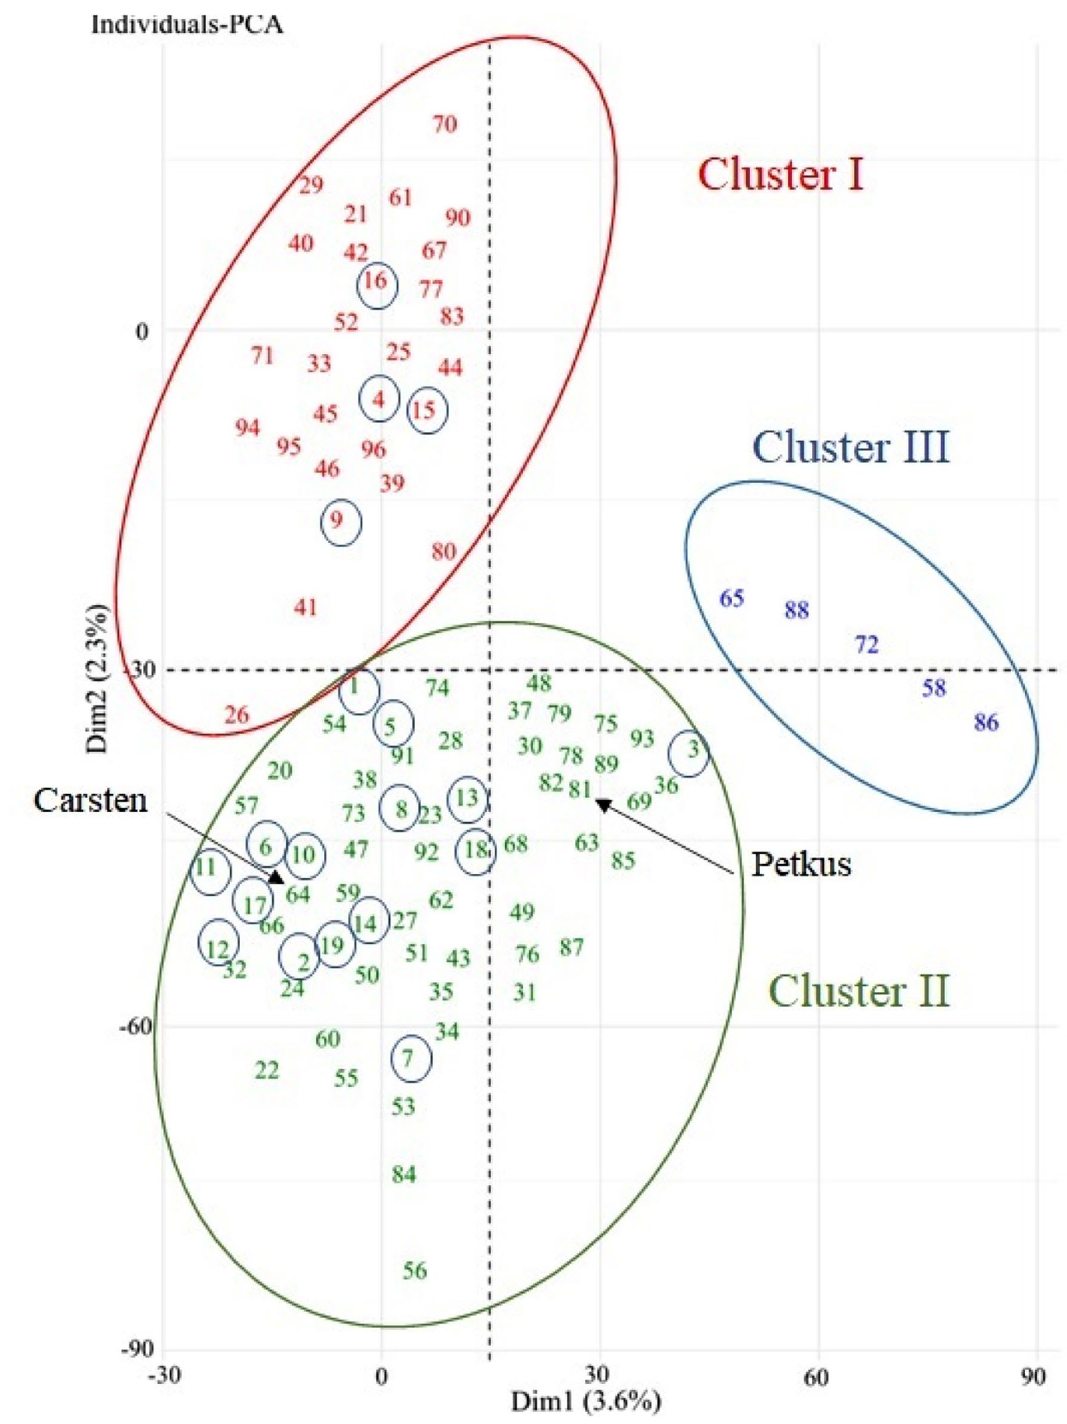
Figure 1. Principal component analysis (PCA) score plot. Plot generated from analysis of 10,244 SNP markers identified in rye population of 96 accessions. The x axis represents the eigenvalue for principal component 1 (PC1) and the y axis for PC2. Genotypes with highest WFS are encircled and arrows refer to less cold hardy Petkus and Carsten, respectively. Data for the individual genotypes is listed in Table